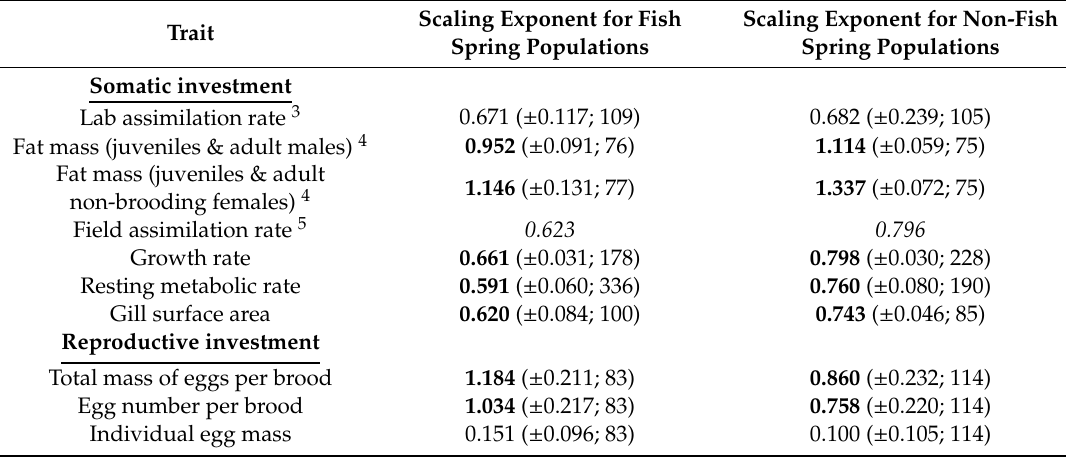
Table 2. Scaling exponents (slopes) 1 of various energetically significant traits in populations of Gammarus minus from springs with versus without fish predators 2 . Scaling Exponent for Fish Scaling Exponent for Non-Fish Trait Spring Populations Spring Populations Somatic